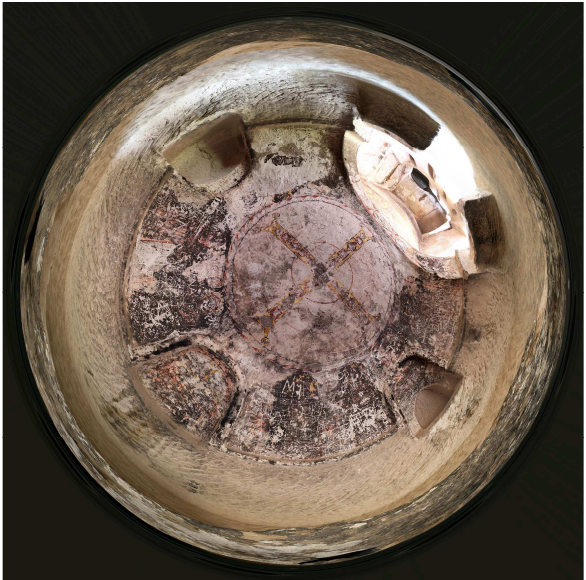
Figure 10. Türkei, Keslik, S. Stephen church, apse, polar projection, M. Carpiceci 2009.